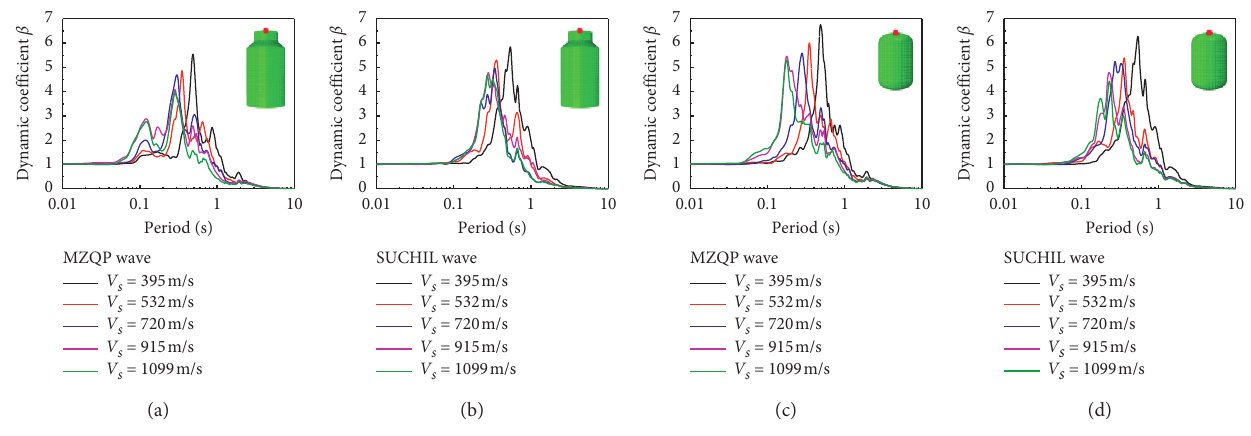
Figure 16: FRS at the top of the SB and SCV. Table 7: PFA and PFRD at the top of the